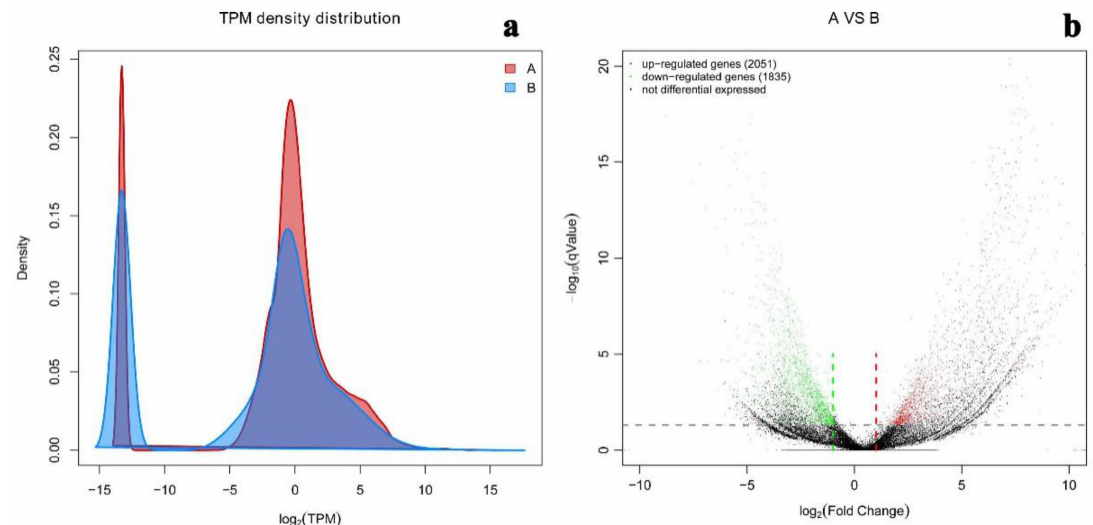
Figure 7. Different gene expression patterns. ( a ) TPM density distribution; ( b ) volcanoplot showing the up and down regulated